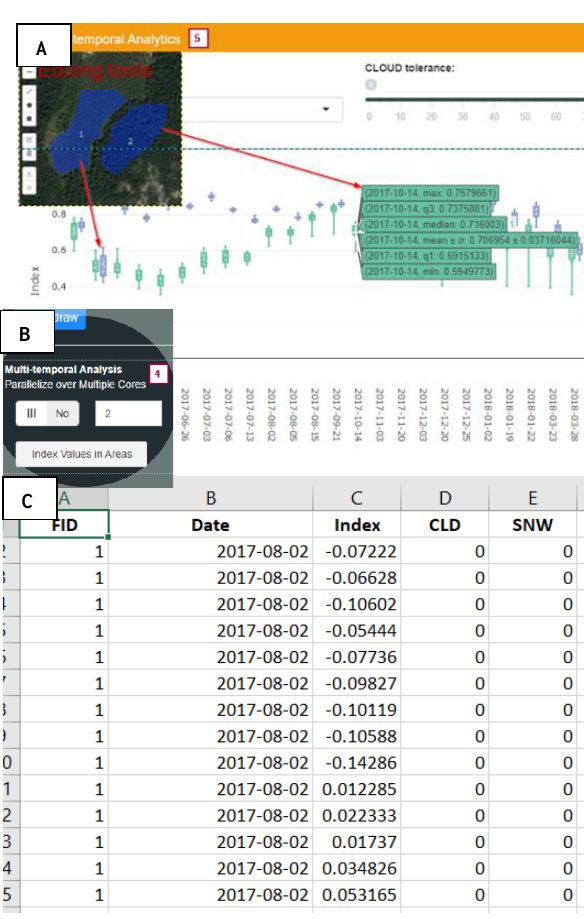
Figure 5. (A) panel area for defining the number of parallel clusters used for running the zonal statistic. (B): results of the analysis, plotted as boxplots for two areas. (C) downloaded Figure 6. (A) burned areas from EFFIS database that occurred table with polygon/point ID and index, cloud and snow in 23 March 2022, Ponte delle Alpi and Longarone locations; probability values. (B) NBR index in GIS environment of the same areas; (C) dNBR index calculated in GIS environment after downloading rasters of